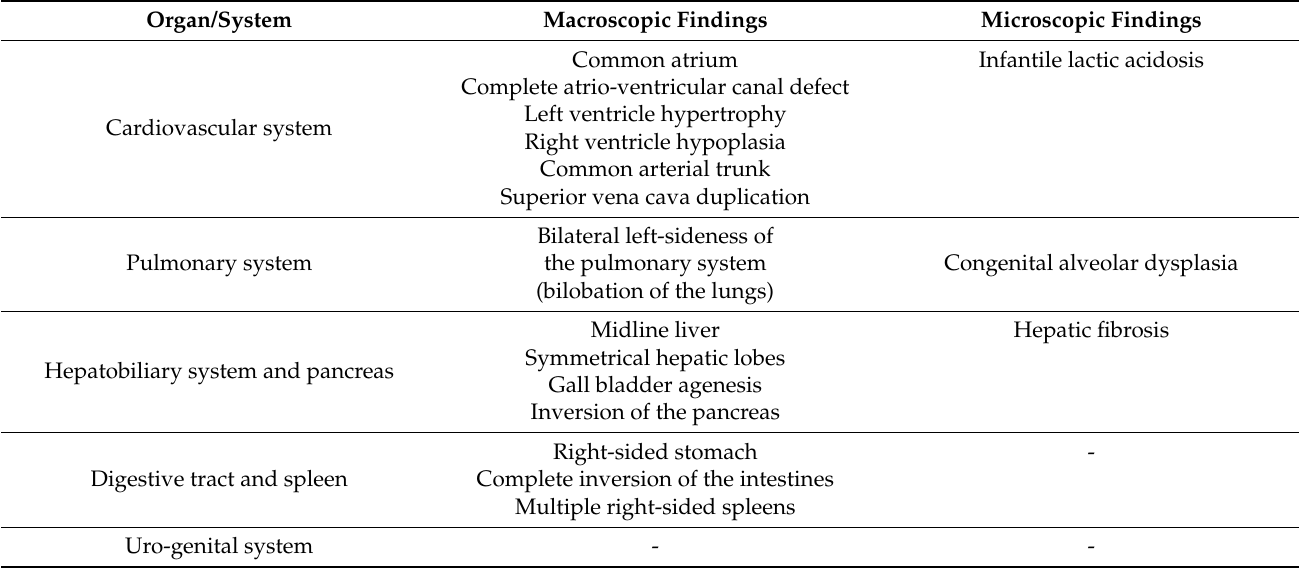
Table 1. Macroscopic and microscopic findings after autopsy and histopathologic